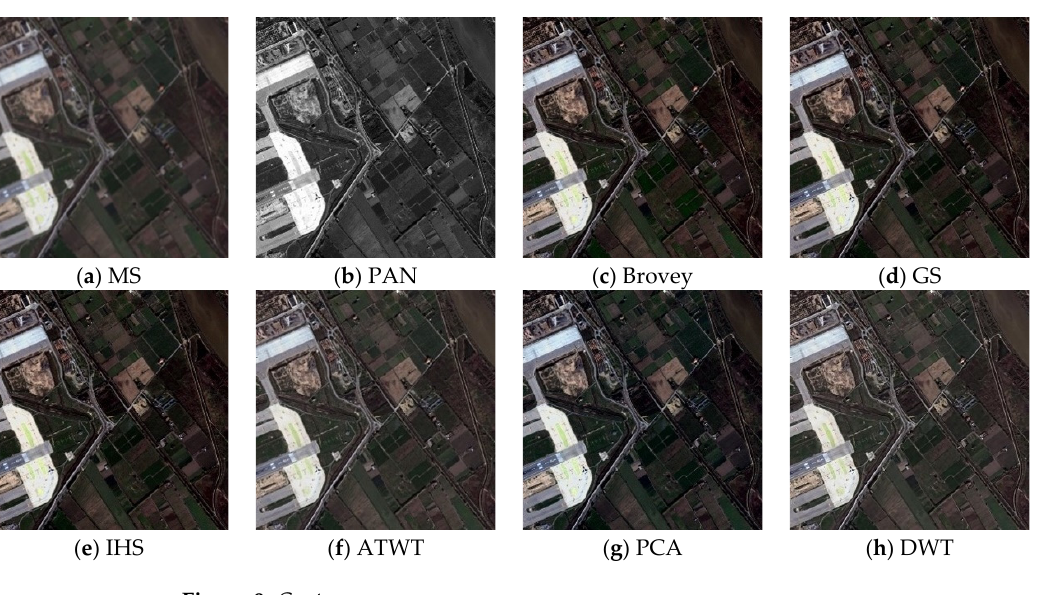
( l ) Ours (128/512) Figure 9. Fusion results for the first group of remote sensing image data. Figure 9 shows the fusion results for the first set of data. As can be seen from Figure 9c–h, although the fusion images obtained by the traditional methods have high spatial resolution, the spectral color is too saturated and there is a large area of spectral distortion. Figure 9i,k show the fusion results of the two deep learning methods, with varying de- grees of spectral distortion and low spatial resolution. The spectral distribution of land- marks and other parts in Figure 9j and the method in this paper (Figure 9l) are more uni- form, and the color effect is closer to the spectral information of MS images. However, in comparison, our method better reflects the high-frequency detail features. In addition, in the wheat field and other large areas where the spectral information is relatively close, the effect of our method is optimal. Table 2 and Figure 10 display the evaluation indexes for the first set of data fusion results, where the bold numbers indicate the best score for each evaluation indexes. Compared with the other seven methods, our method achieves better results for all of the evaluation indexes. These quantitative results, in conjunction with the subjective visual results in Figure 9, show that our method outperforms existing fusion methods.